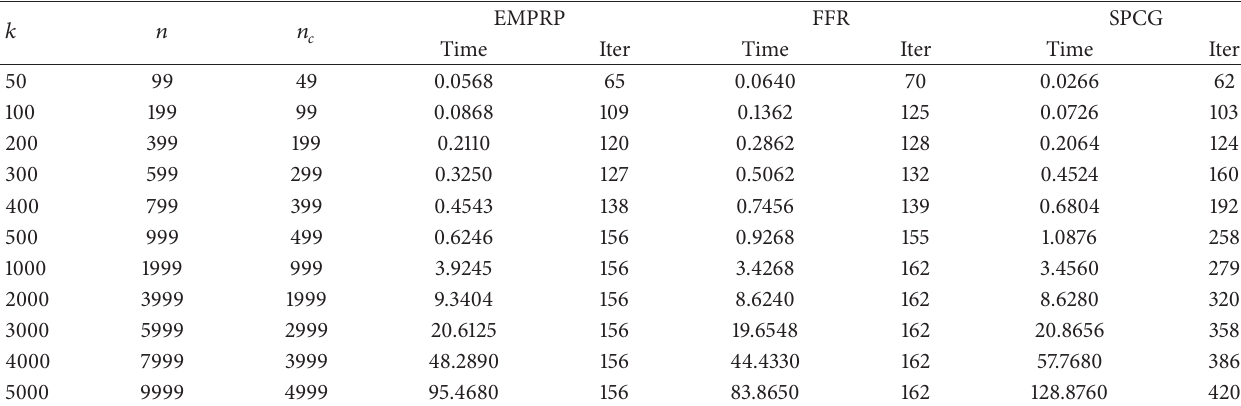
Table 5: Test results for Problem 9 with given initial